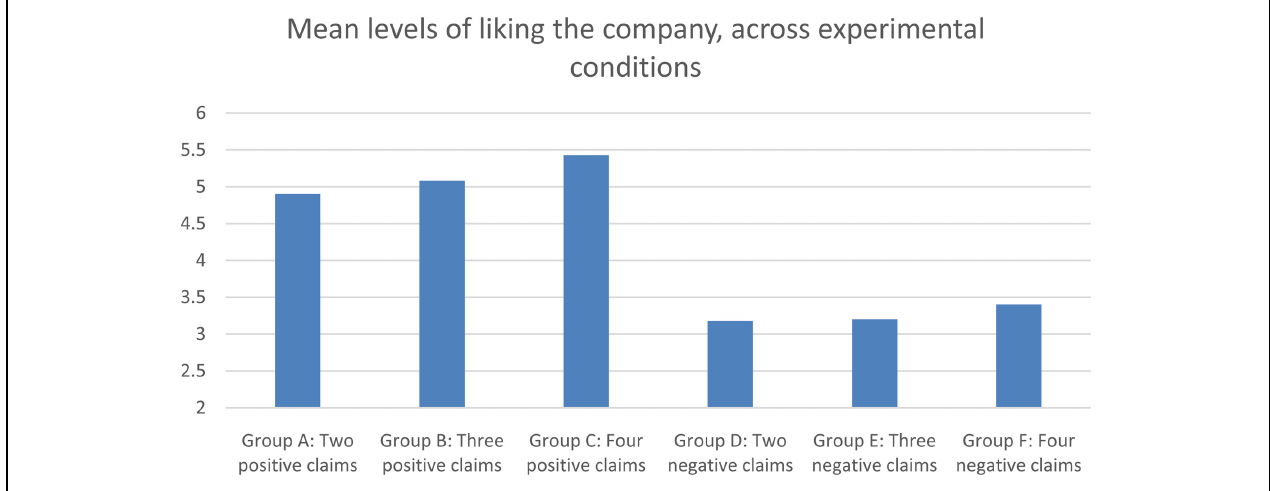
FIGURE 1 | Single item response of how much the subjects like the company, across experimental